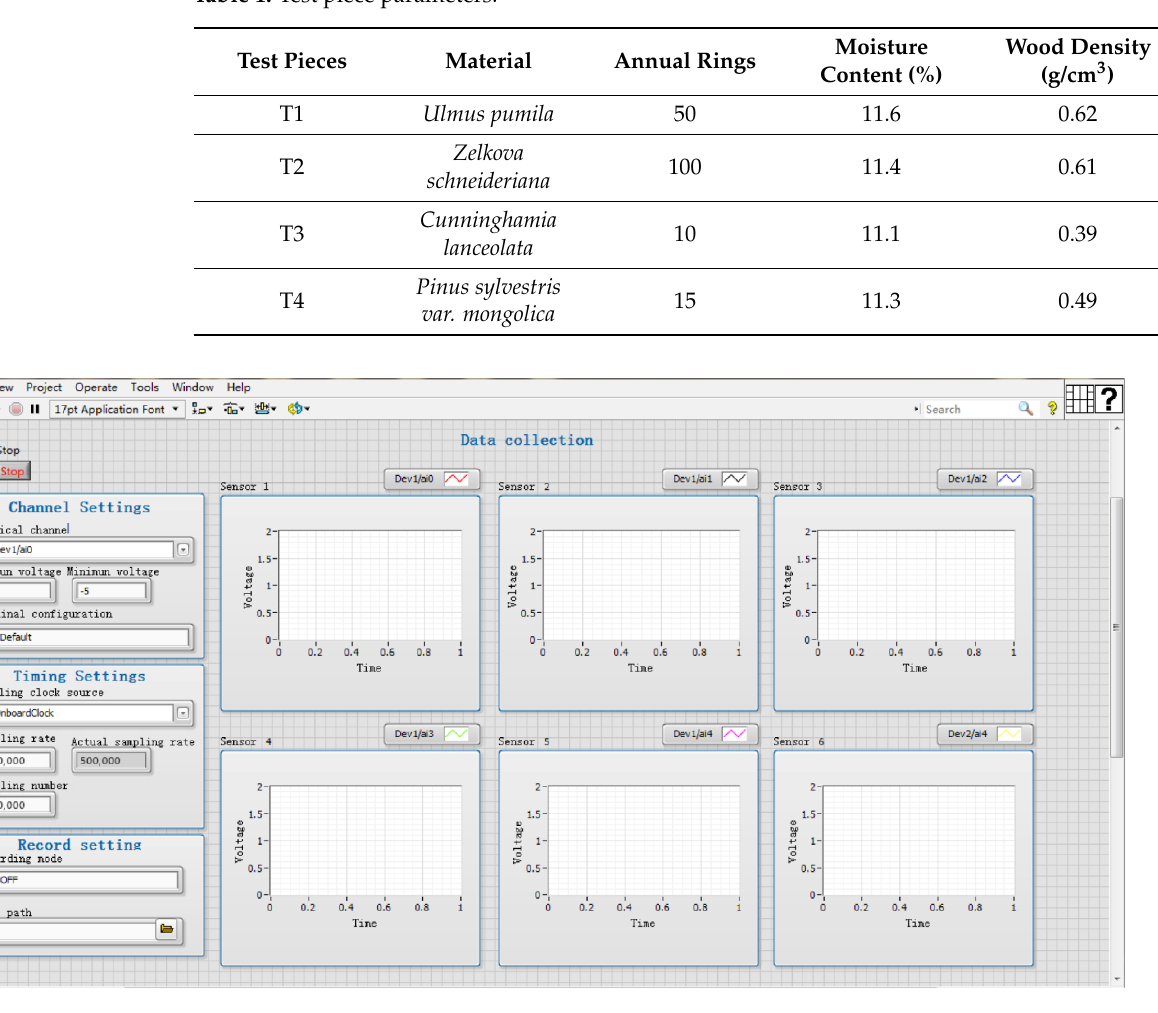
Table 1. Test piece parameters.